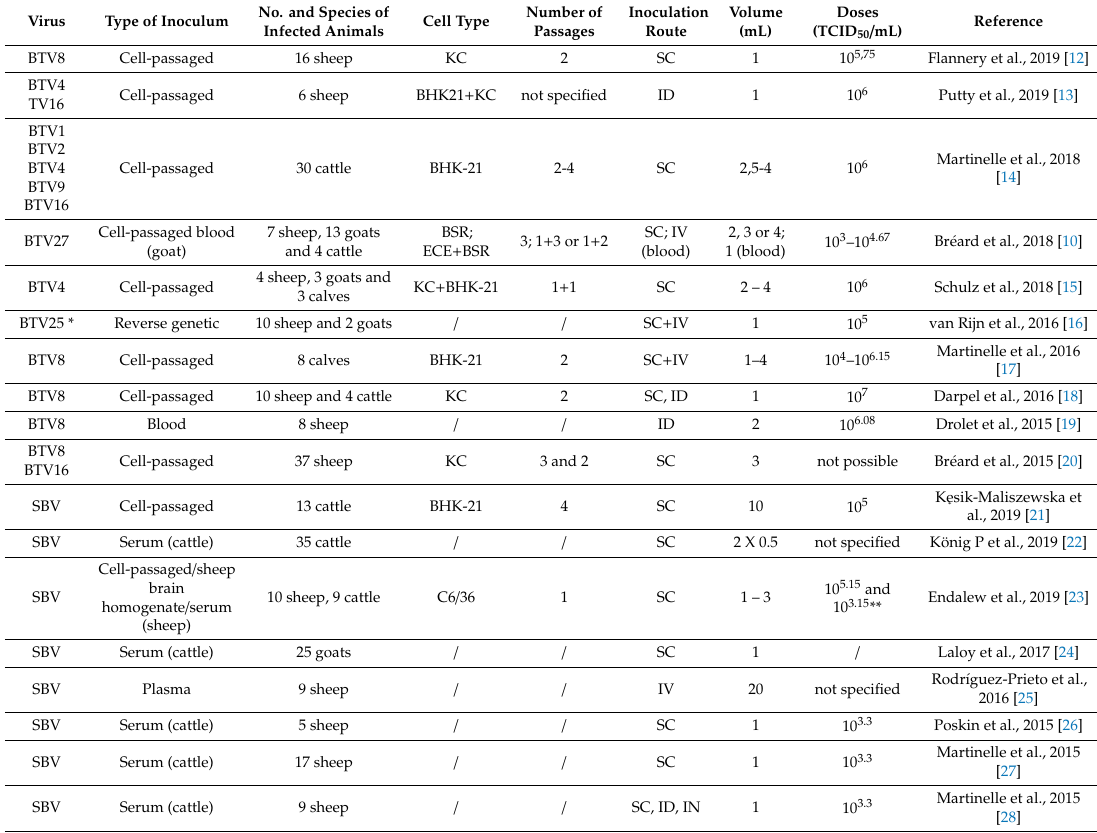
Table 1. Inocula characteristics used in the 10 most recent experimental infection studies on BTV and SBV (as searched on PubMed (July 2019) with keywords “experimental infection bluetongue” and “experimental infection Schmallenberg”). Only articles about experimental infection involving at least one ruminant species among cattle, sheep or goats were retained. The number of infected animals only takes into account actually infected ones, excluding control animals.